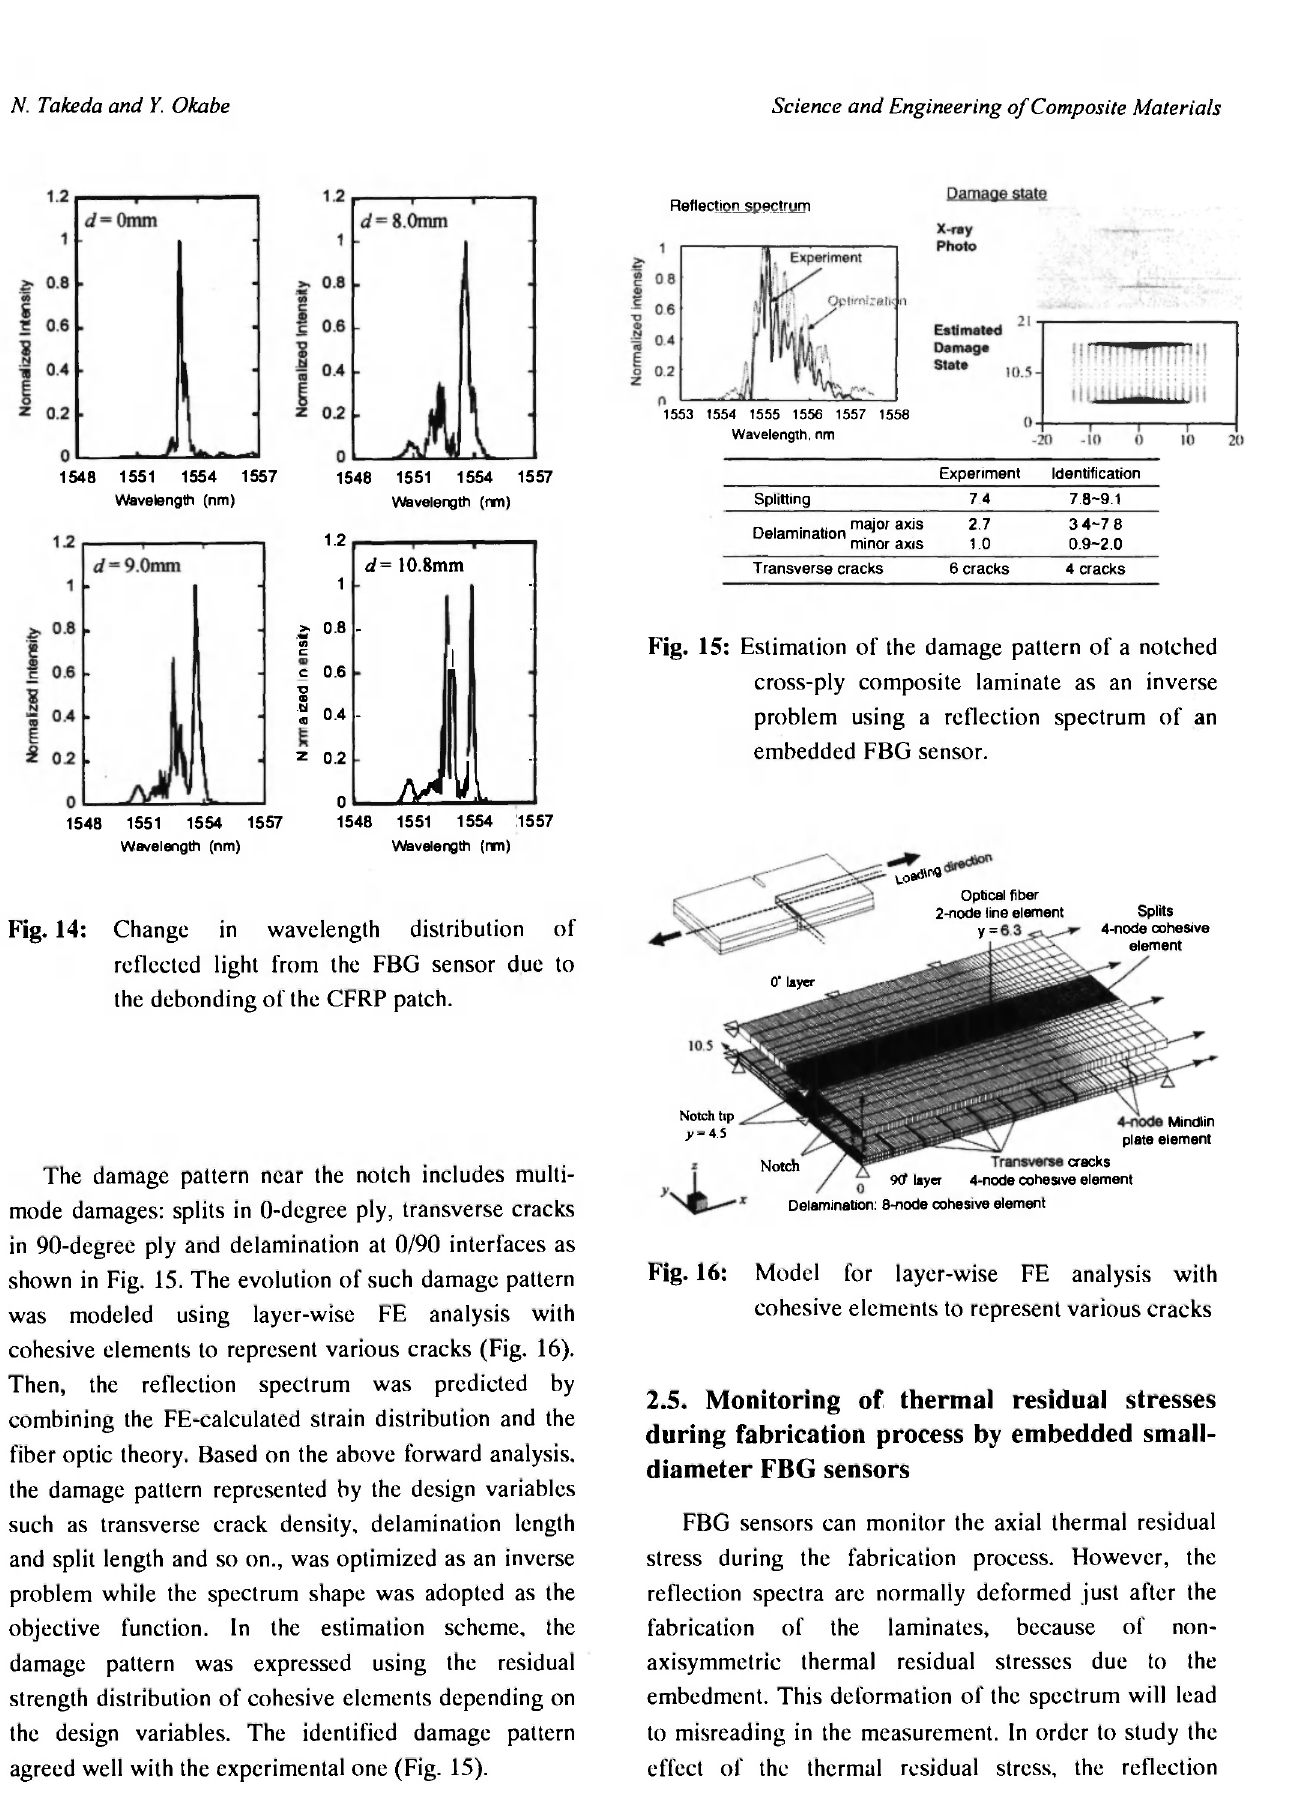
axisymmetric thermal residual stresses due to